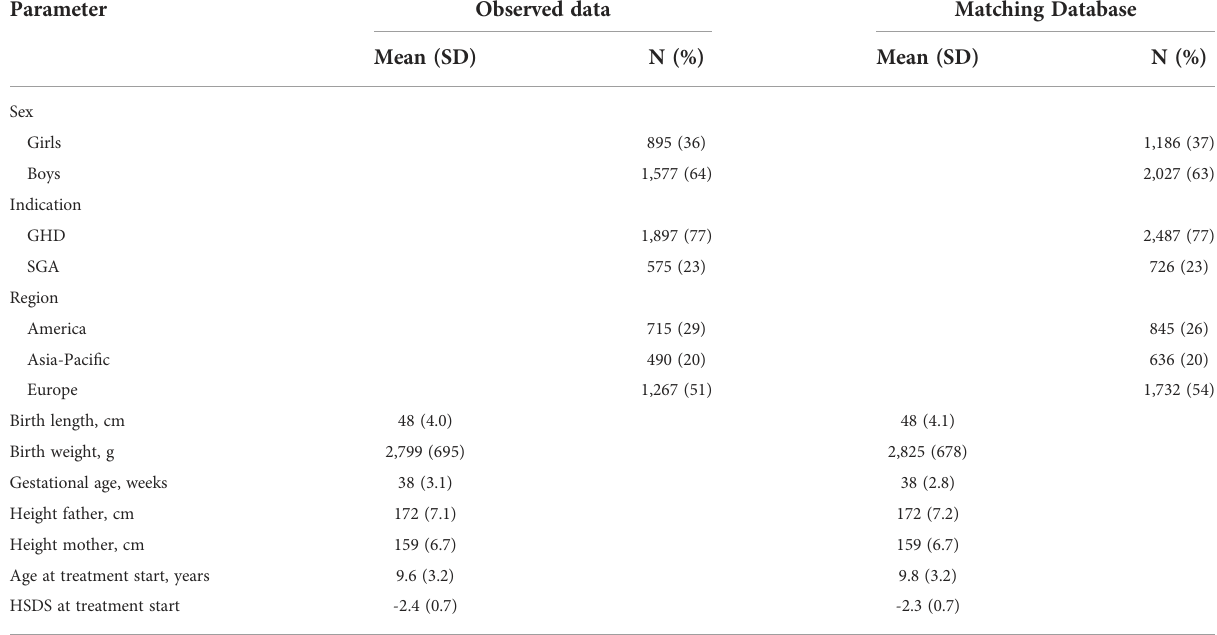
TABLE 1 Clinical parameters and background characteristics of the observed data (n = 2,472) and the ‘ Matching Database ’ (n = 3,213).